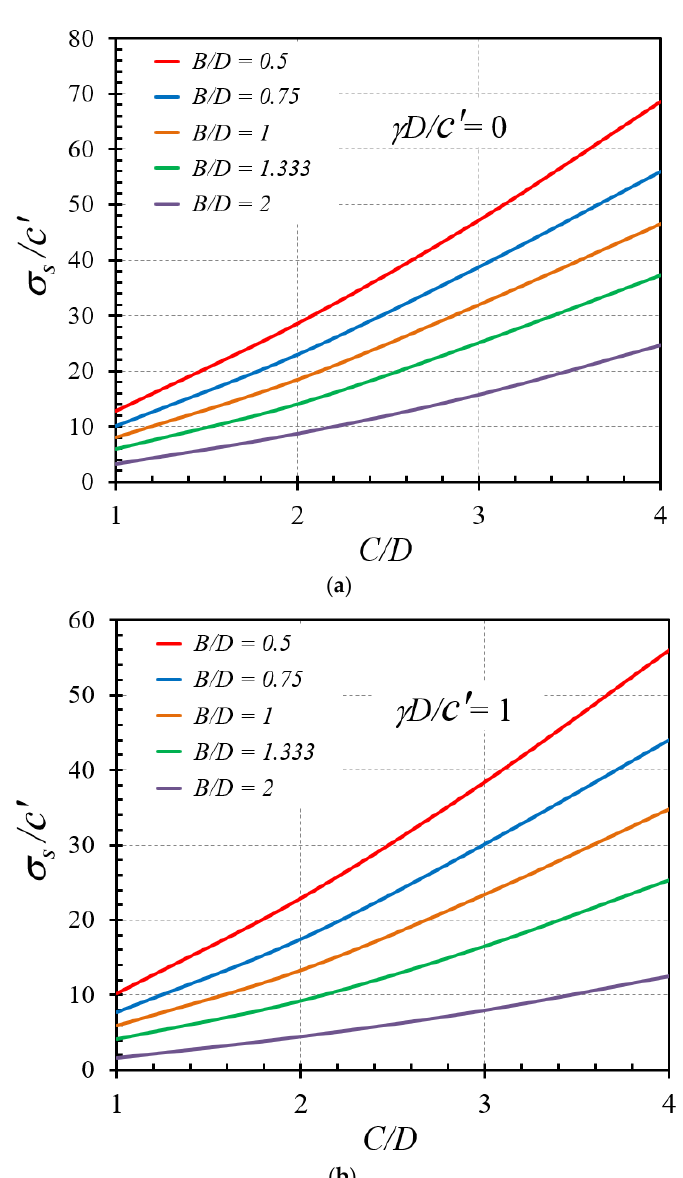
Figure 4. Influence of γ D/c' on the stability factors σ s /c' of horseshoe tunnels with C/D = 4: ( a ) ϕ = 0° and ( b ) ϕ = 5°.